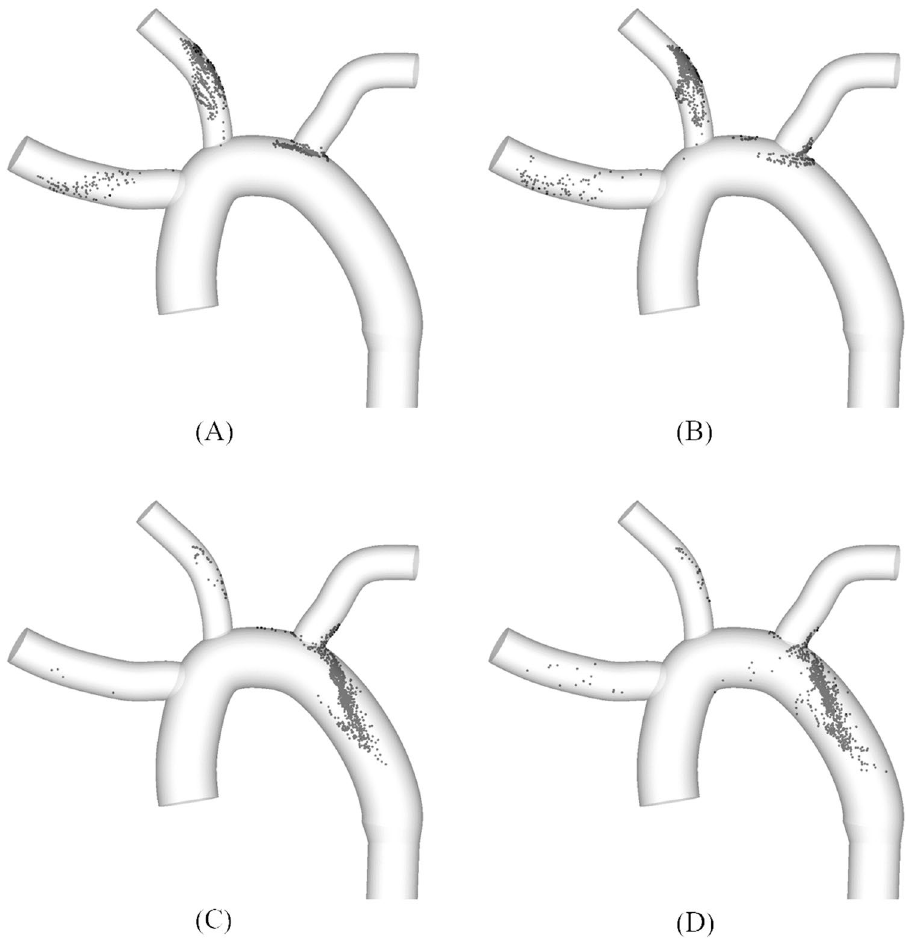
Figure 2. Distribution of clots within the idealized aorta model at the end of second systolic stage of a normal cardiac cycle after release of clots at the aortic inlet with application of ( A ) drag force + buoyancy force ( B ) drag force + buoyancy force + virtual mass force ( C ) drag force + buoyancy force + pressure gradient force, and ( D ) drag force + buoyancy force + virtual mass force + pressure gradient force on the